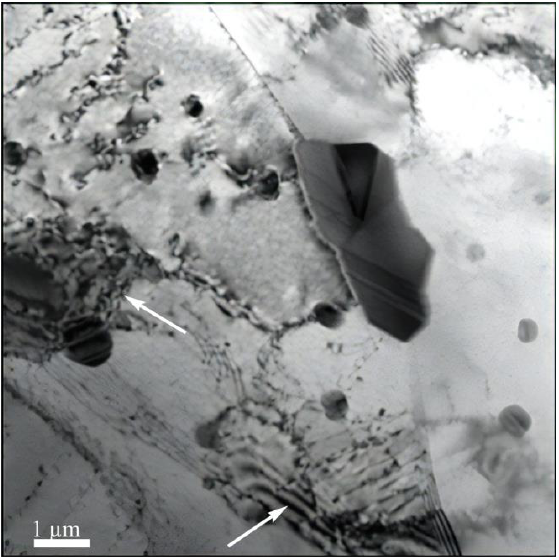
Figure 9. TEM—the alloy structure 2024-T351 after DNP ( ε imp = 3.72%); Arrows show block-structure forming zones.